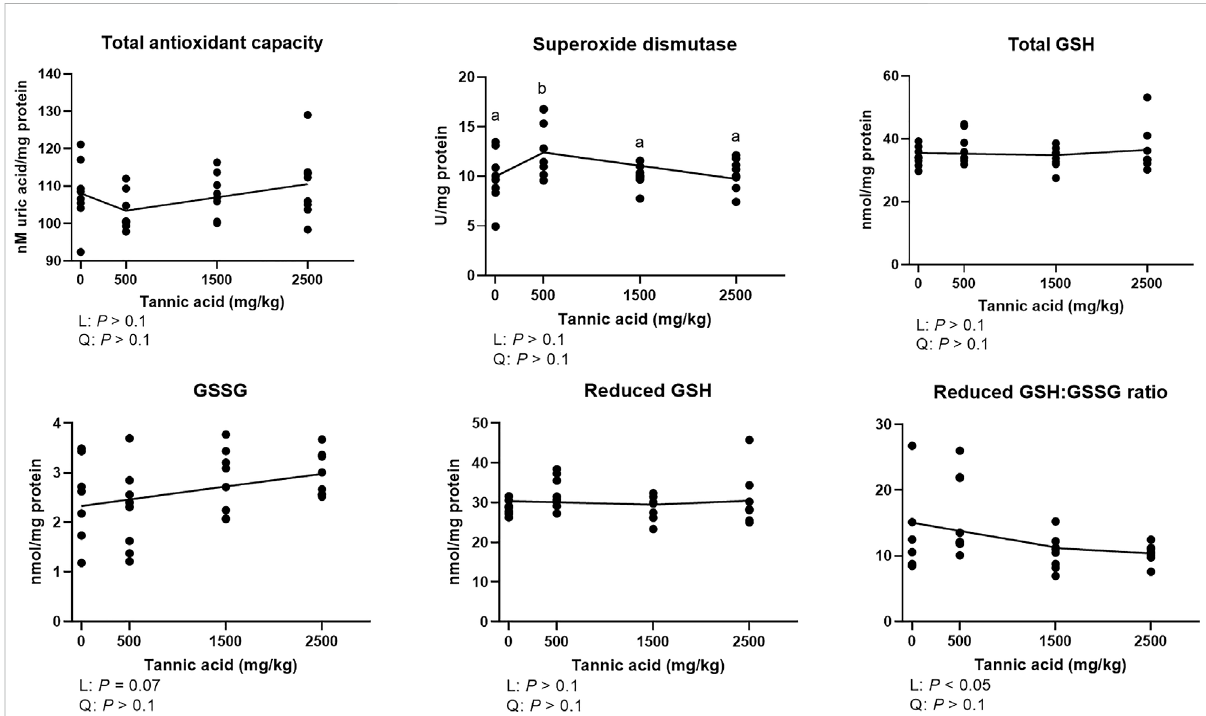
FIGURE 6 Total antioxidant capacity, glutathione (GSH) and oxidized glutathione (GSSG) concentrations, and activities of superoxide dismutase (SOD) in broiler chickens fed different concentrations (0, 0.5, 1.5, and 2.5 g/kg) of tannic acid on D 21. The treatment groups were compared using one-way ANOVA followed by the Tukey ’ s multiple comparison. Different superscripts differ at p < 0.05. Orthogonal polynomial contrasts analysis was conducted to see linear pattern (L) and quadratic pattern (Q) among the treatments. To calculate the optimal dosage of tannic acid in broilers, segmented linear regression was conducted, and X0 (in fl ection point) with p values for slope 1 (lower than X0 ) and slope 2 (higher than X0 ) were presented. Reduced GSH = Total GSH – 2 ×